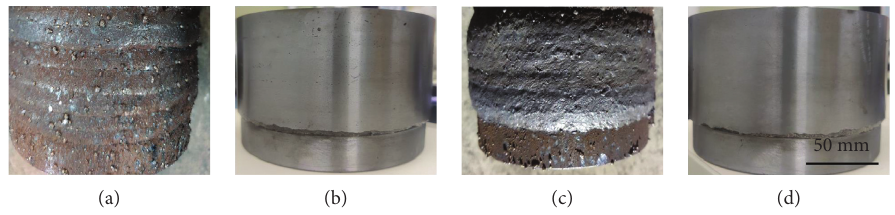
Figure 13: Digital photos of the Q235 steel pipe after (a, b) cladding; (c, d) partially cladded layer is removed by turning (a, c) AW and (b, d)